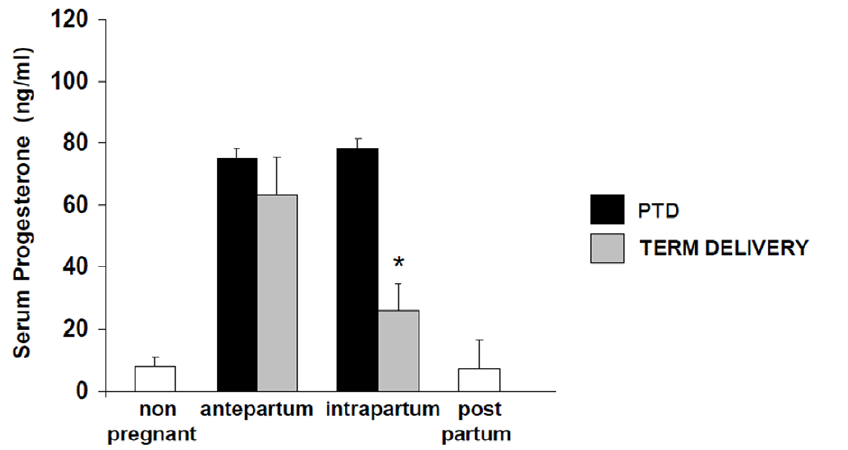
Figure 1. Serum progesterone levels in PTD and term delivery. Antepartum LPS serum samples were collected at day 15 of pregnancy, intrapartum LPS samples at days 16 and 17, antepartum term samples at days 17, 18 and 19 and intrapartum term at days 20 and 21. Note that progesterone levels drop dramatically near parturition time (days 20 and 21) in control mice at term while LPS-treated mice that delivered preterm did not show changes in progesterone levels. * Different from antepartum, P , 0.05. 3 to 5 samples were analyzed at each time point.